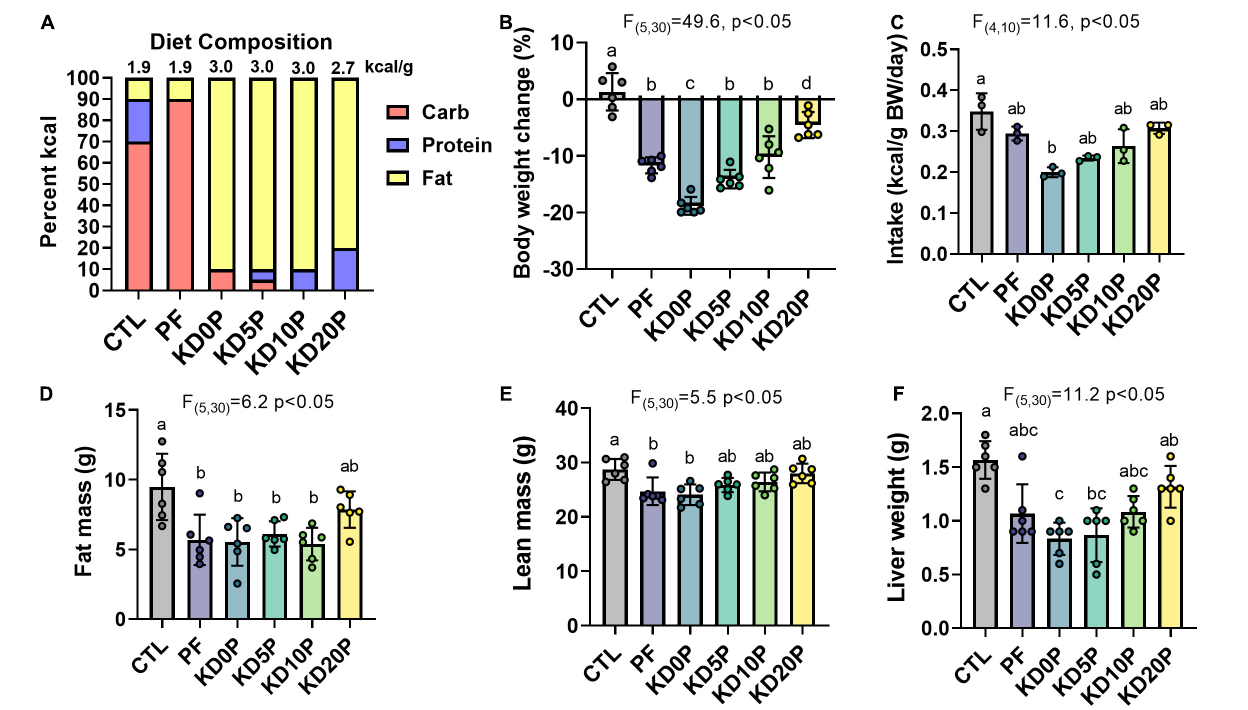
FIGURE 1 | Short-term dietary protein or carbohydrate restriction alters body composition. Male B6D2F1 mice were fed one of six diets for 8 days ( n = 6 per diet) with varying macronutrient compositions as depicted in (A) . The energy density of each diet is listed above the associated bar. (B) Changes in body weight after 8 days of diet shown as the percent of the initial weight. (C) Average energy intake across 8 days of diet feeding. Intake was normalized to the summed body weight of 2 mice co-housed per cage and presented per cage. Fat mass (D) and lean mass (E) quantified by EchoMRI at the end of the diet period. (F) Liver weights at sacrifice after 6 h fasting period. Statistical analysis was performed by one-way ANOVA with Tukey’s multiple comparison test (A–D) . Different letters indicate significant differences ( p < 0.05), with common letters indicating no significant difference between groups. Values are represented as mean ±